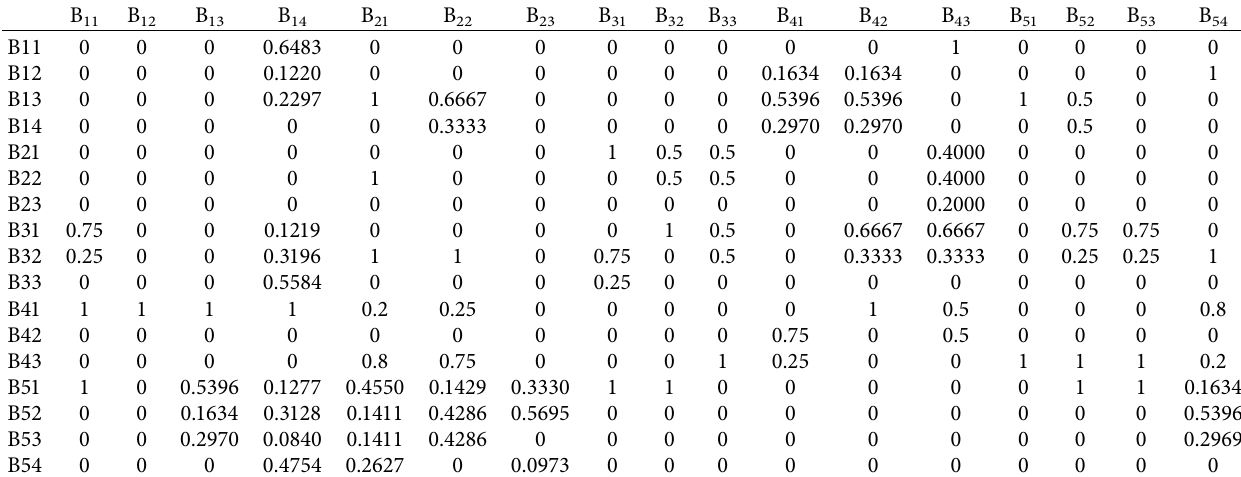
Table 5: ANP initial